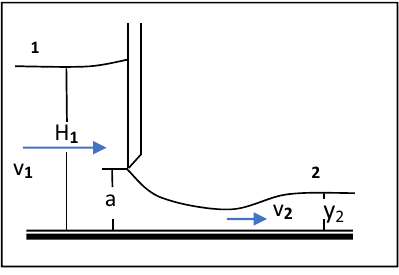
Figure 6: Applying the Bernoulli equation on the sluice gate.